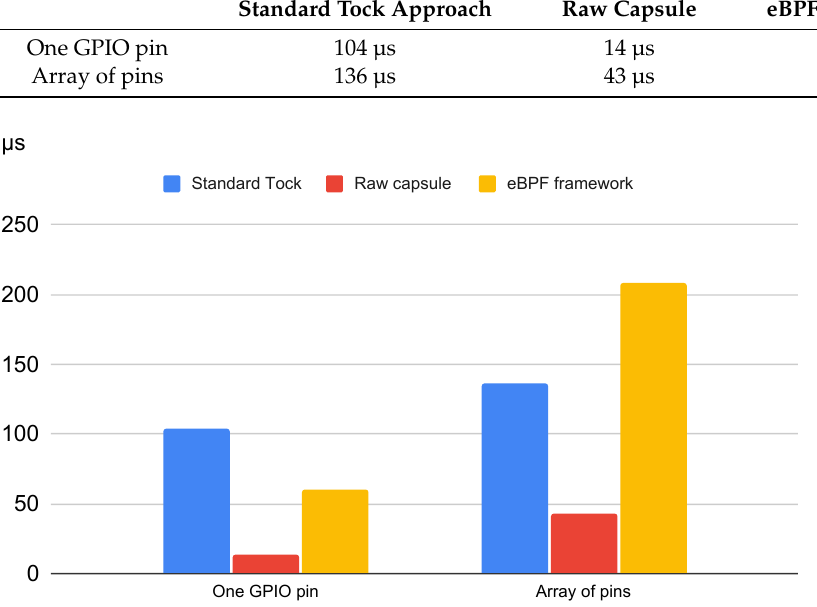
Figure 6. Interrupt handling